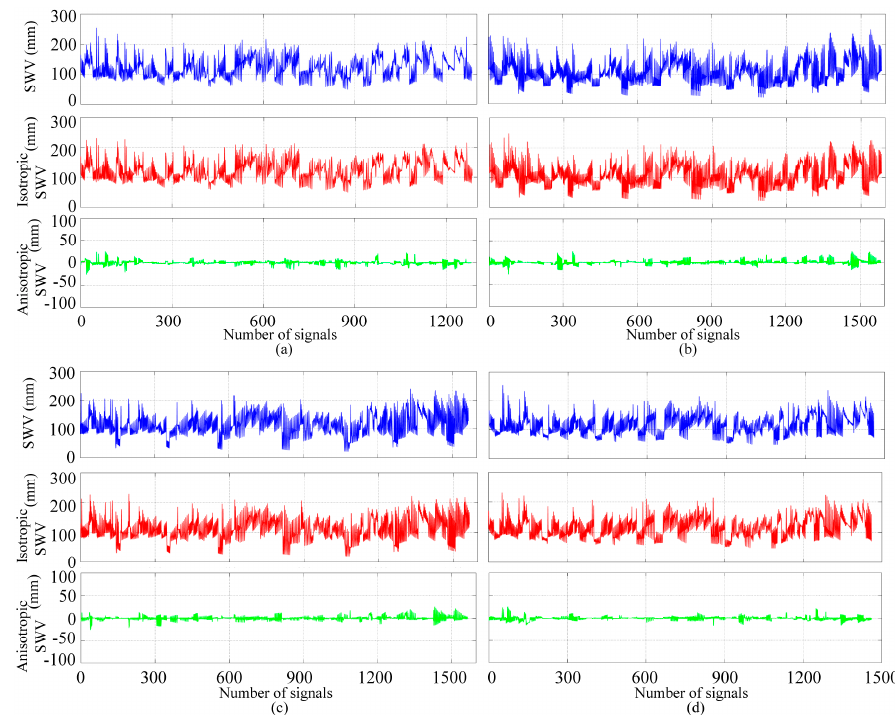
Figure 9. The slant water vapor (SWV) value of inside signals in four schemes: top for total SWV, center for isotropic SWV, and bottom for anisotropic SWV, respectively. (a) Scheme East; (b) Scheme West; (c) Scheme South; and (d) Scheme North.